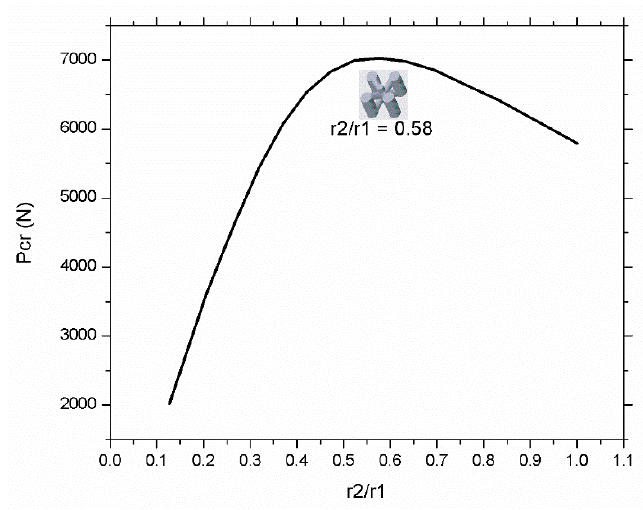
Figure 11. Showing the effect of r 2 /r 1 ratio on critical buckling load and the optimal value of